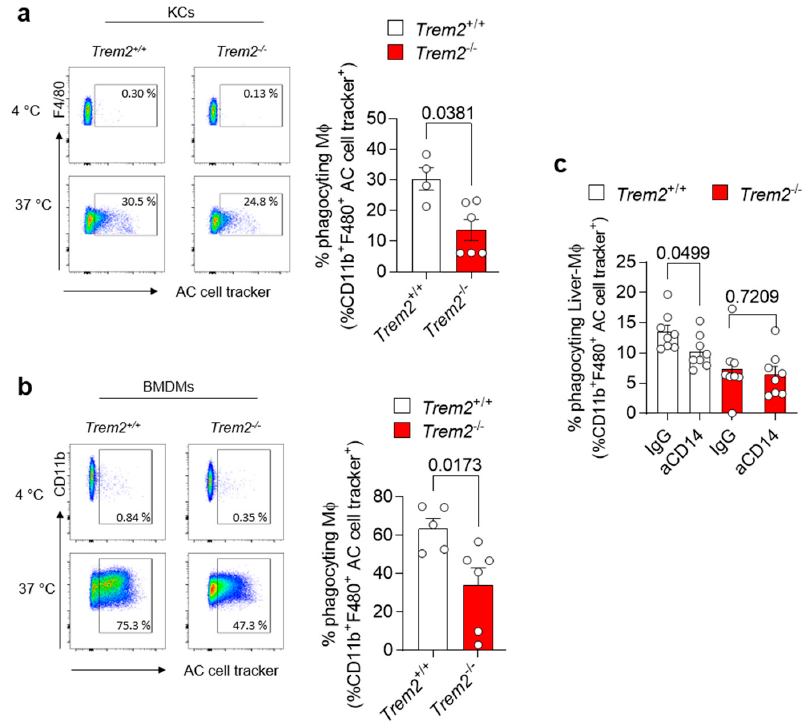
Figure 3. Trem2 regulates KC-dependent uptake of apoptotic cells ( a ) KCs were isolated from WT ( Trem2 +/+ ) and Trem2 − / − mice and incubated with labeled aHs at 4 °C (binding control) and 37 °C (binding+uptake); (left panel): gating strategy, (right panel): quantification of phagocyting macrophages ( n = 4–5). ( b ) BMDMs were isolated from WT ( Trem2 +/+ ) and Trem2 − / − mice and incubated with labeled apoptotic hepatocytes at 4 °C (binding control) and at 37 °C (uptake); (left panel): gating strategy (right panel): quantification of phagocyting macrophages ( n = 5–6). ( c ) Hepatic macrophages were isolated from WT ( Trem2 +/+ ) and Trem2 − / − mice, pre-treated with control (IgG) or anti-CD14 antibody (aCD14), stimulated with LPS for 20 h and incubated with labeled aHs. Phagocyting macrophages were quantified ( n = 8). Data are shown as mean + SEM. Statistically significant differences between groups ( p < 0.05) were determined by Mann–Whitney test ( a , b ) and Student’s t -test ( c ) and are indicated as p -value.